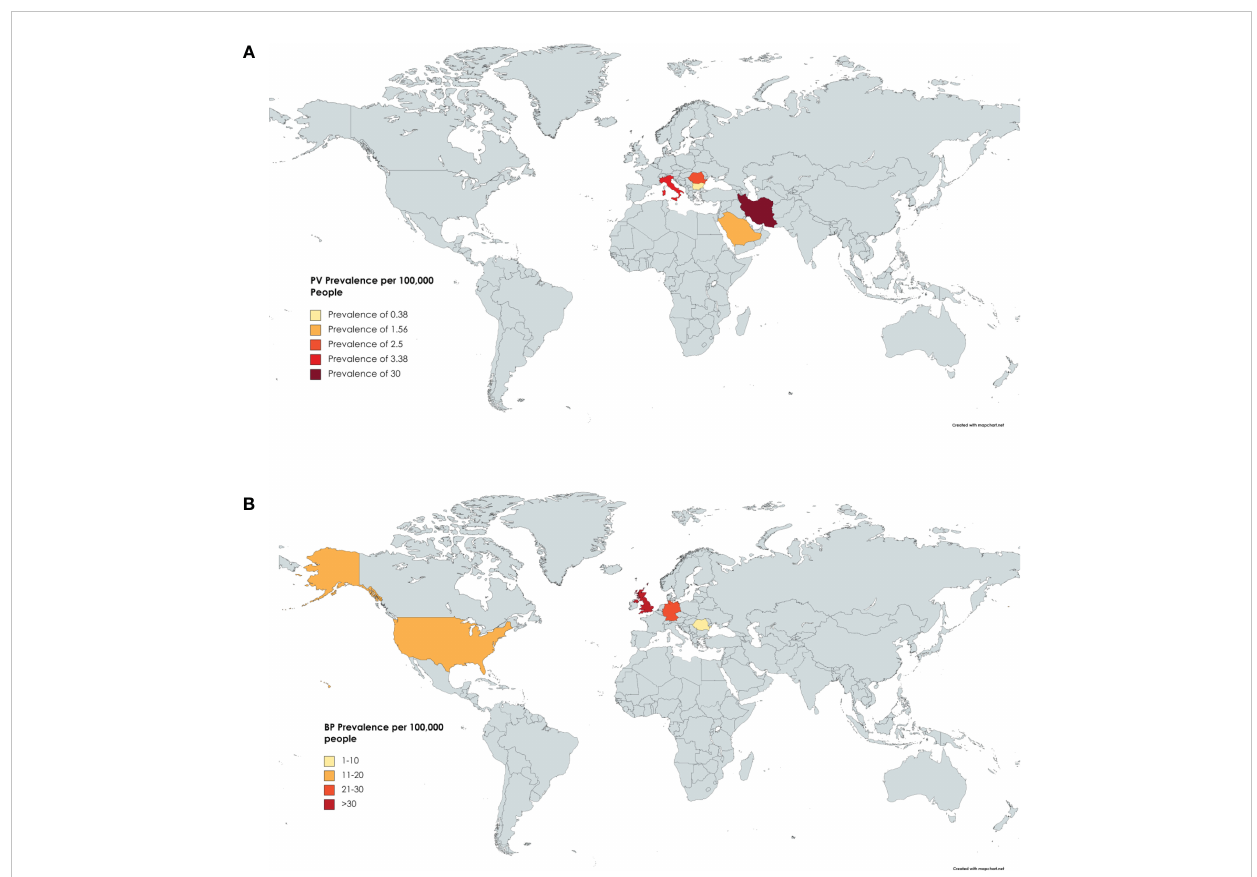
FIGURE 1 Prevalence by Country. (A) Countries include Iran, Italy, Germany, Romania, Saudi Arabia, and Bulgaria. Darker shading signi fi es higher PV prevalence. Speci fi c values can be found in Table 1A. (B) Countries reporting BP prevalence include the USA, UK, Romania, and Germany. Speci fi c Values can be found in Table 1B.